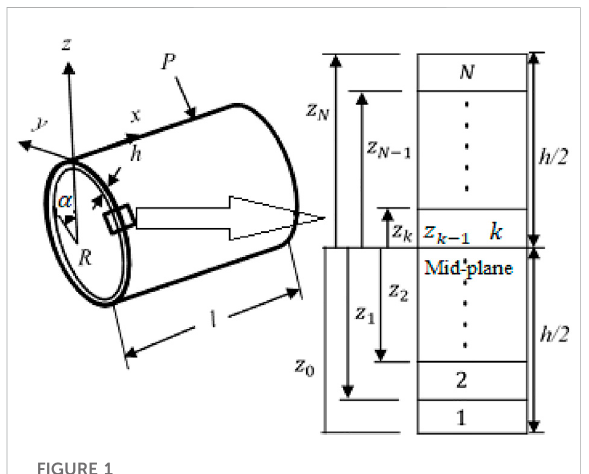
FIGURE 1 Geometry and coordinates of plies of submersible shell.